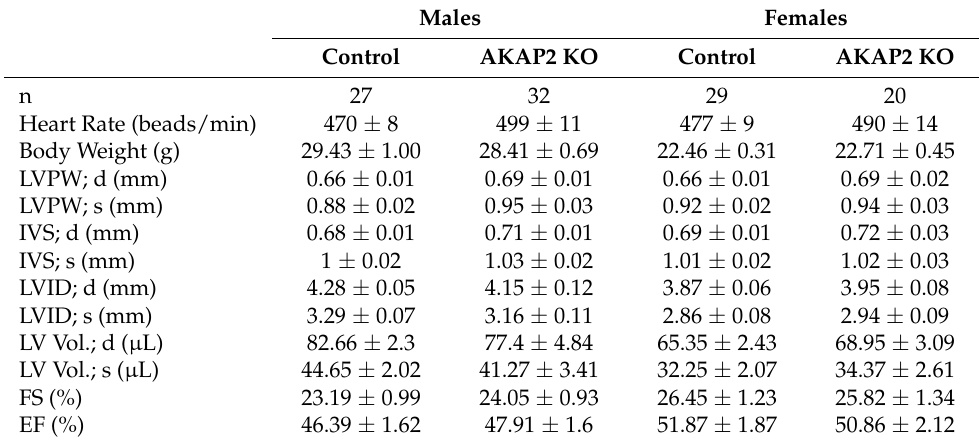
Table 1. Physiological and echocardiographic parameters in control and AKAP2 KO mice at baseline. Males Females Control AKAP2 KO Control AKAP2 KO 27 32 29